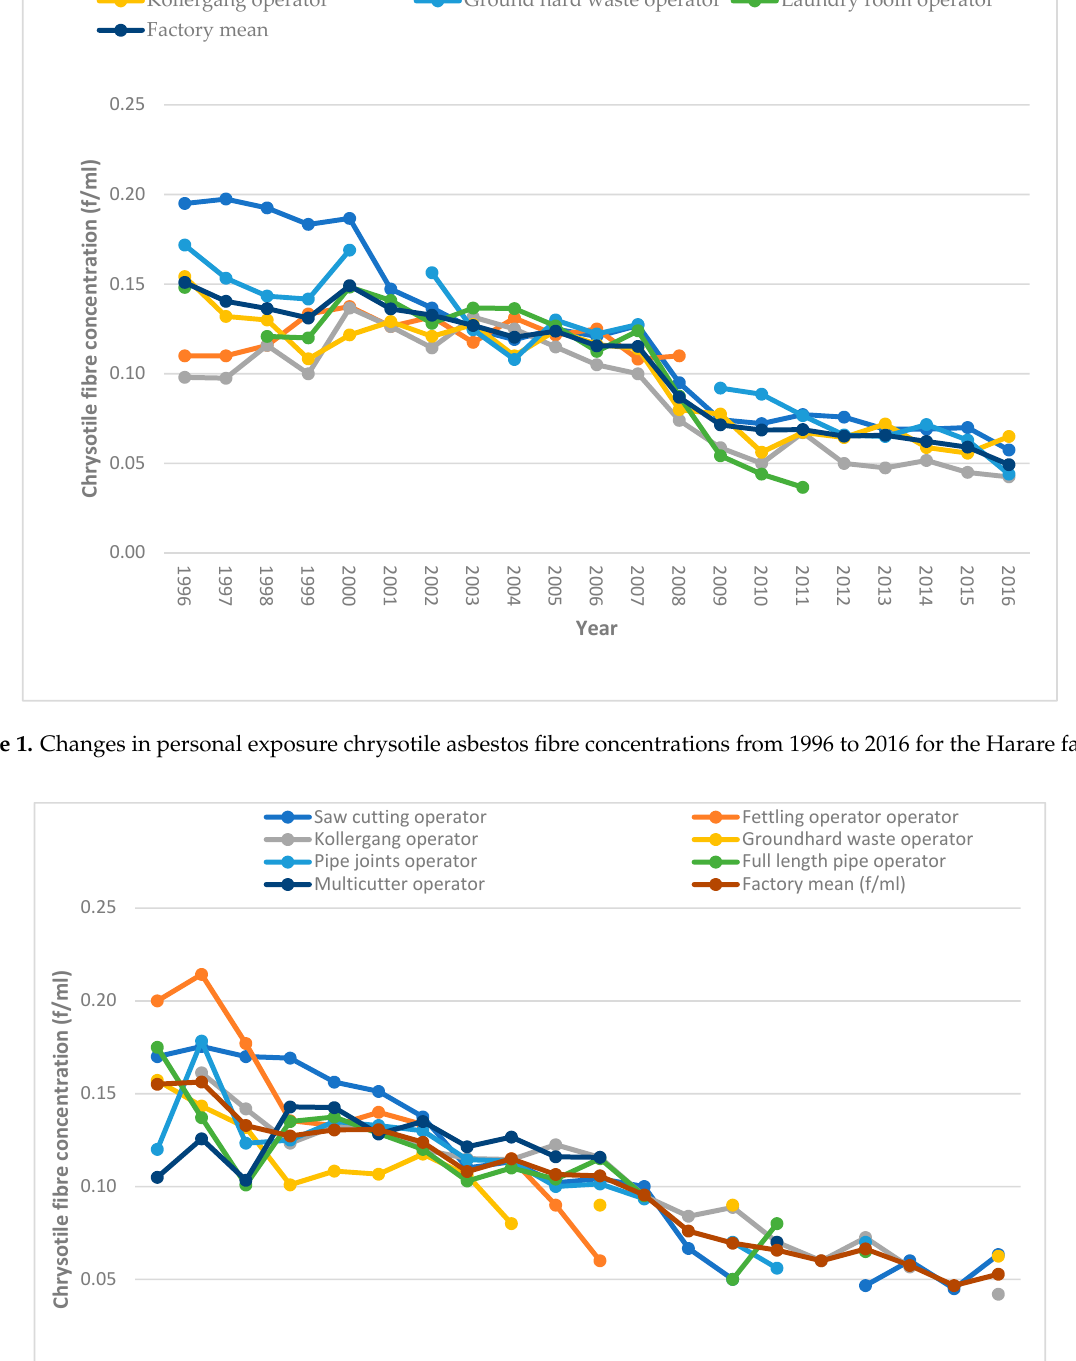
Figure 2. Changes in personal exposure chrysotile asbestos fibre concentrations from 1996 to 2016 for the Bulawayo